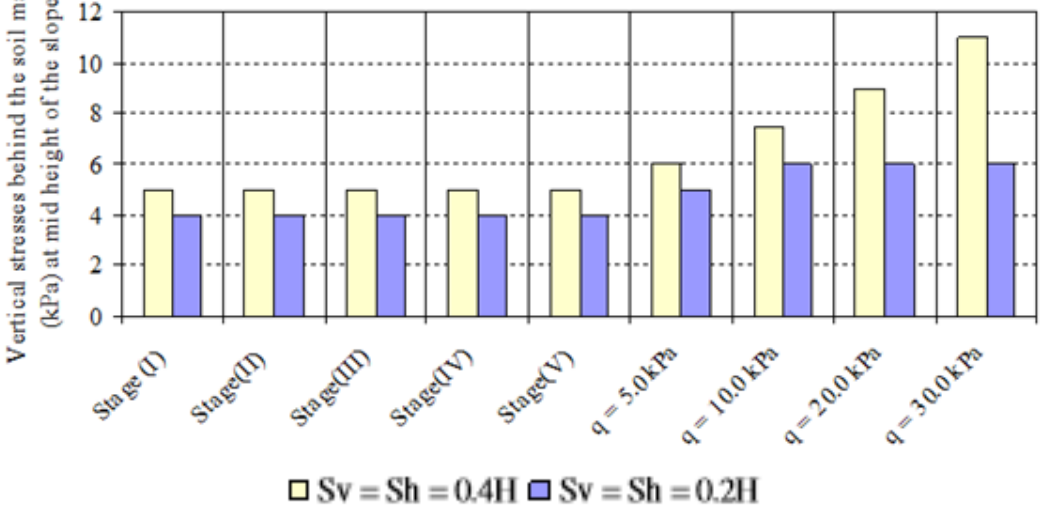
Figure 27. Influence of nail inclination on horizontal stresses behind the nailed soil mass at mid height of slope.